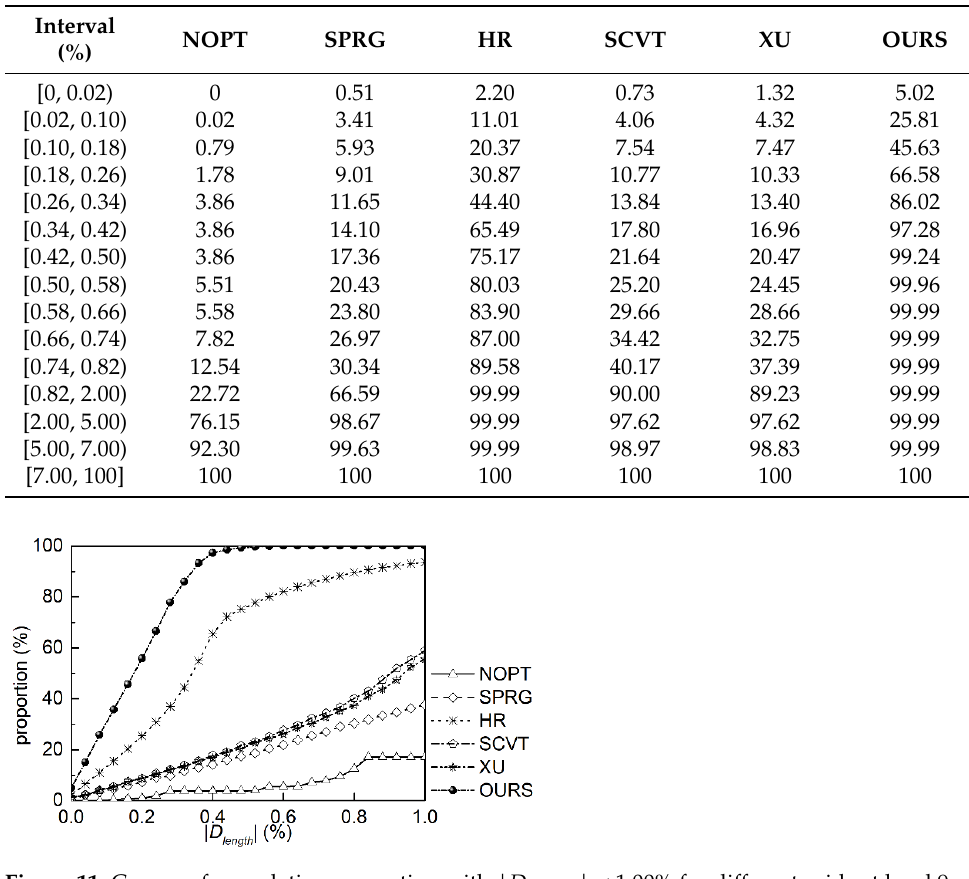
Figure 11. Curves of cumulative proportion with | D length | < 1.00% for different grids at level 9. The D length of all grids are in [ − 15%, 21%] (Table 8), and the ones of HR grid and OURS grid are mainly in ( − 1%, 1%). The proportion of grid in this range of OURS grid is about 7 times that of NOPT grid, although the interval ratio of NOPT grid is bigger than that of